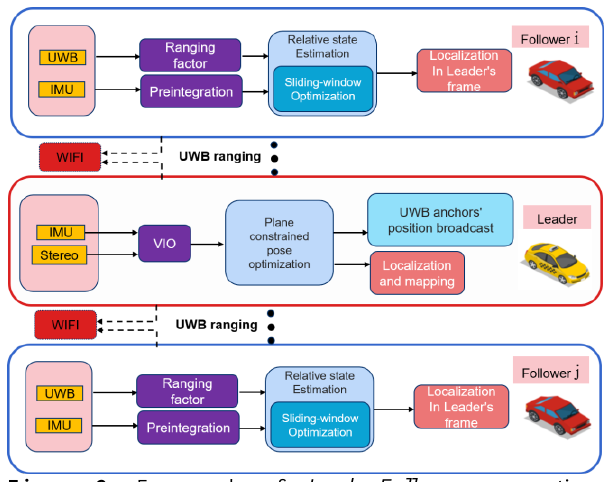
Figure 2 . Framework of Leader - Follower cooperative localization system. The Leader runs VIO for self_localization, assuming that there is a rigid connection between UWB anchors and AGV body, and broadcasts the pose through WiFi. The Follower run the tightly coupled graph optimization algorithm for relative state